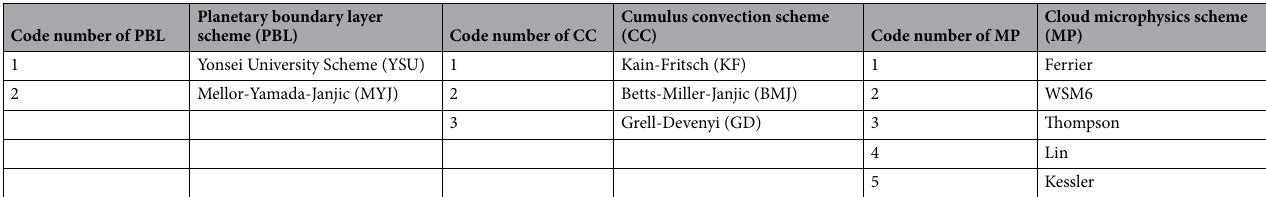
Table 1. Physical parameterization schemes selected for the combinatorial